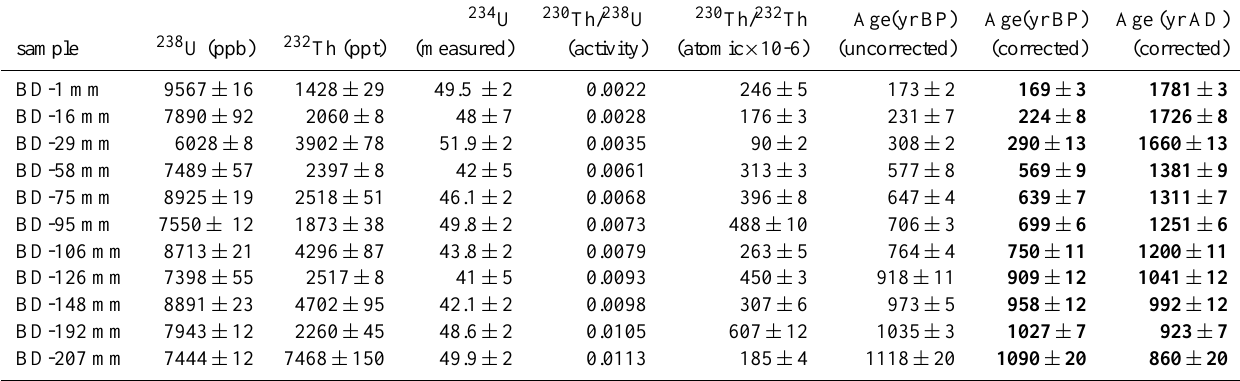
Table 1. Uranium and thorium isotopic compositions and 230 Th ages for sample BD by ICP-MS. The corrected ages are indicated in bold.